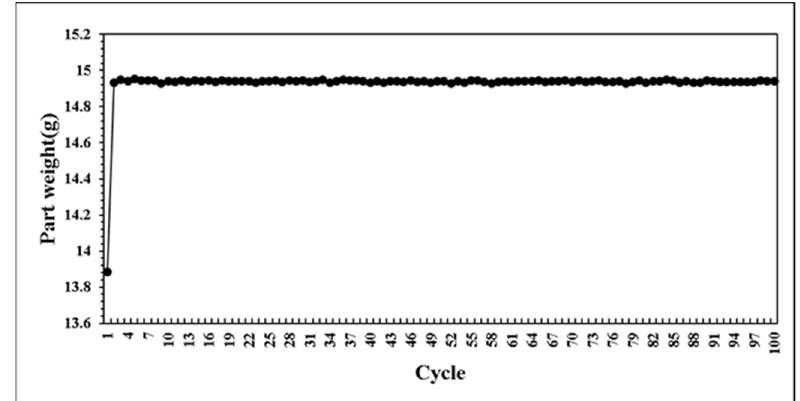
Figure 23. Distribution of timing of peak pressure in experiment.